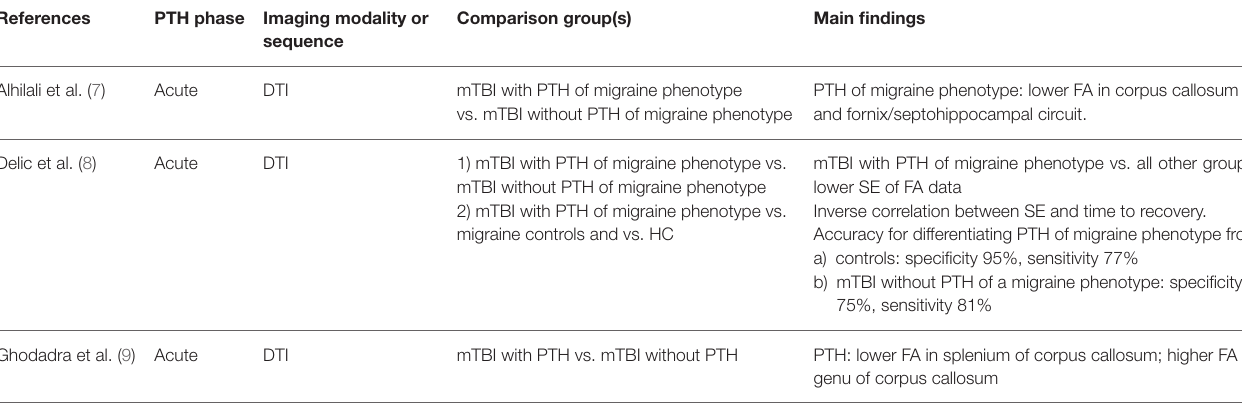
TABLE 1 | Imaging findings during acute post-traumatic